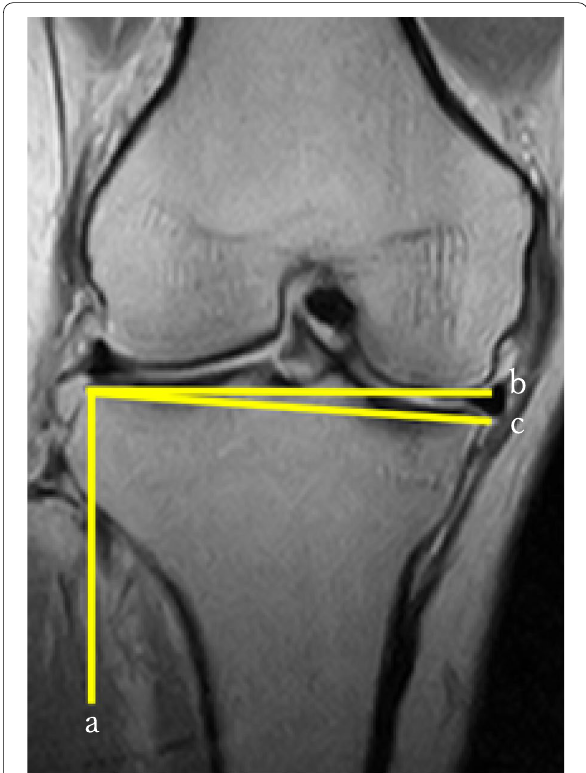
Fig. 4 Measurement of medial tibial medial slope (MTMS). a : Parallel line of the diaphyseal tibial axis in the coronal slice determined by an axial view of the tibial plateau; b : Perpendicular line to the line a from the lateral-most point of the tibial joint surface; c : Line connecting the lateral-most and medial-most points; MTMS was determined as the angle between lines b and